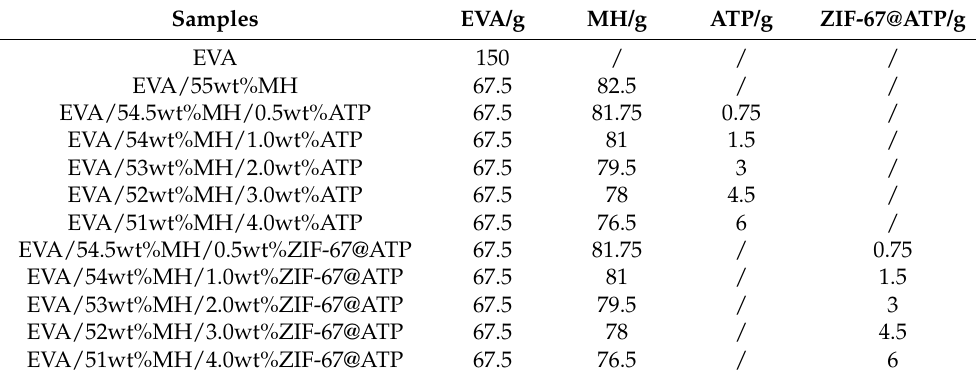
Table 1. Notation and composition of EVA/MH/ZIF-67@ATP composites.